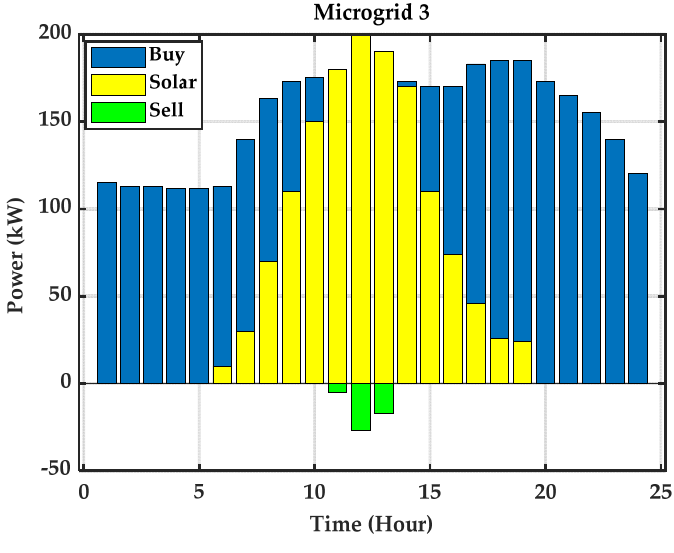
Figure 11. Microgrid 3 response.